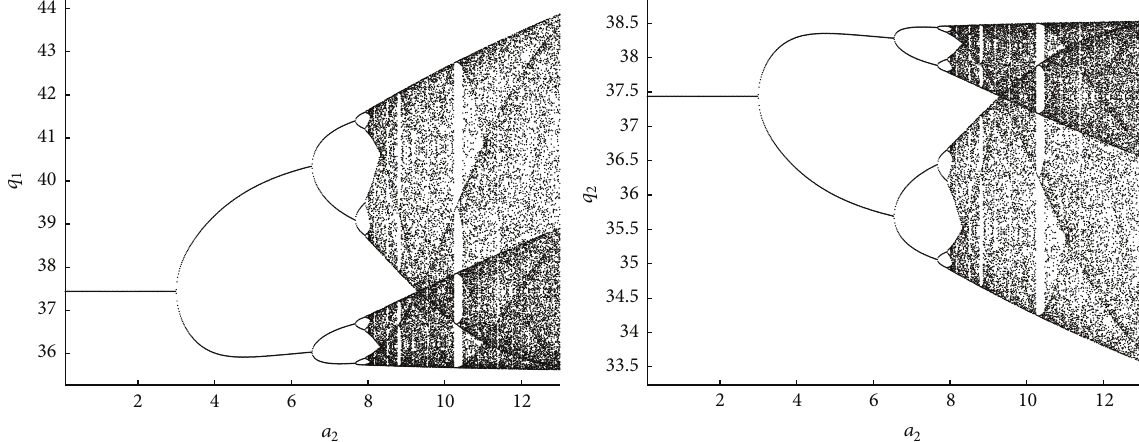
Figure 5: Bifurcation diagrams of quantities 𝑞 1 and 𝑞 2 with respect to the lower bound of production variation −𝑎 2 . Increasing 𝑎 2 , namely, decreasing the lower bound −𝑎 2 , leads to